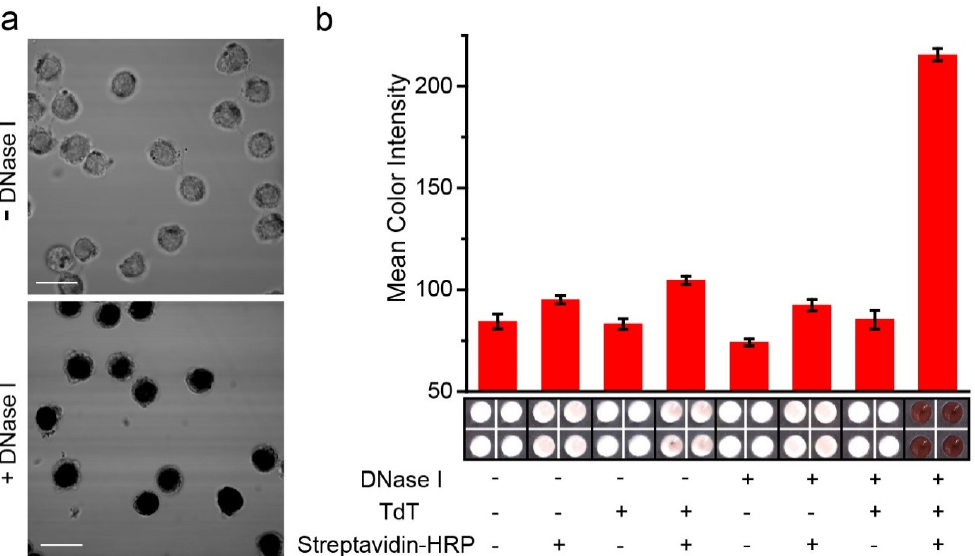
Figure 1. ( a ) CLSM images of DAB color reaction in DNase I-treated ZFL cells. Scale bar: 10 µ m. Control group without DNase I treatment was set for comparison. ( b ) The photograph and the color intensity of the paper chips. Lanes 1–7 represent various controls. The error bars represent standard deviations of four independent experiments.